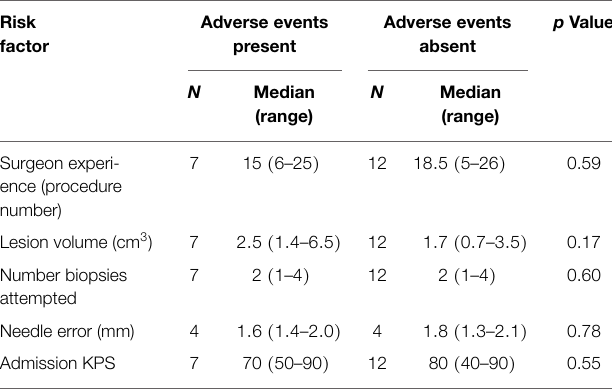
TABLE 5 | Analysis of continuous risk factors for the development of adverse events associated with stereotactic brain biopsy . Risk Adverse events factor